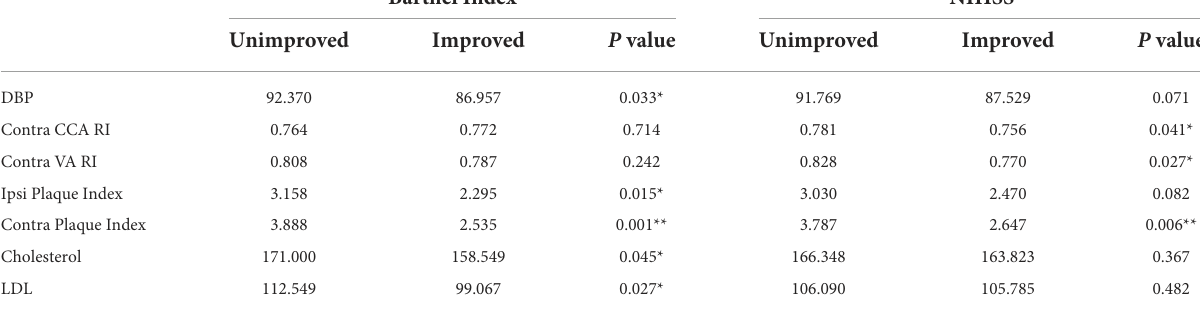
TABLE 3A Important baseline variables for Barthel Index and